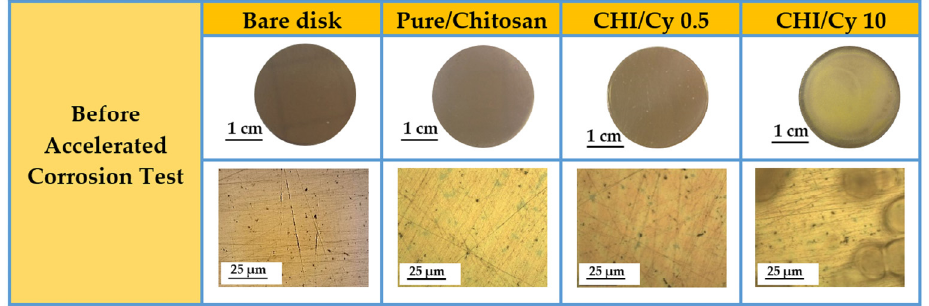
Figure 1. General appearance and OM micrographs of the Cu-based alloy, Cu-based alloy coated with a thin film of chitosan without inhibitor and with different concentrations of Cysteine: 0.5 mg/mL and 10 mg/mL. For all samples the scale bar corresponds to 25 μ m.